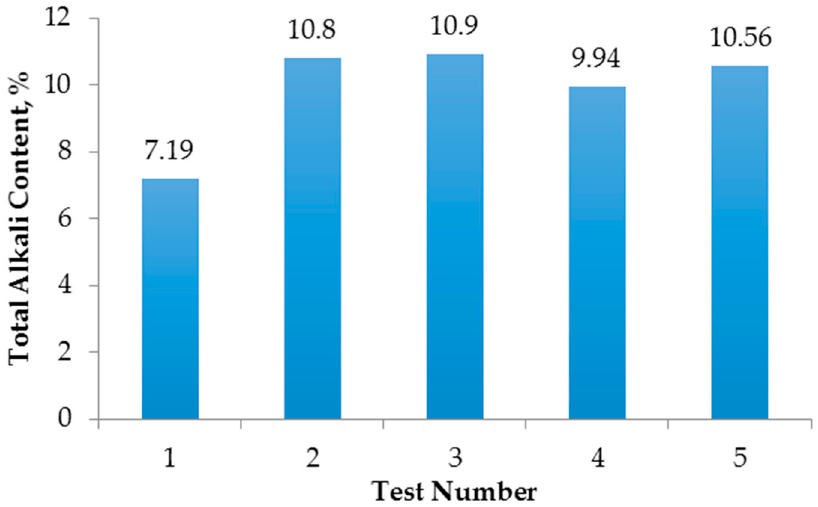
Figure 6. Total alkali (Na 2 O + CaO) content of feldspar concentrates for each test.